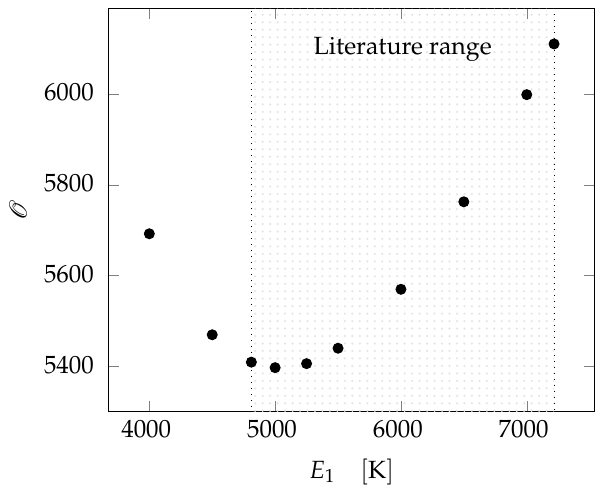
Figure 3. Minimization of the objective function O to find fitting parameter E 1 . The range indicated by [18] is